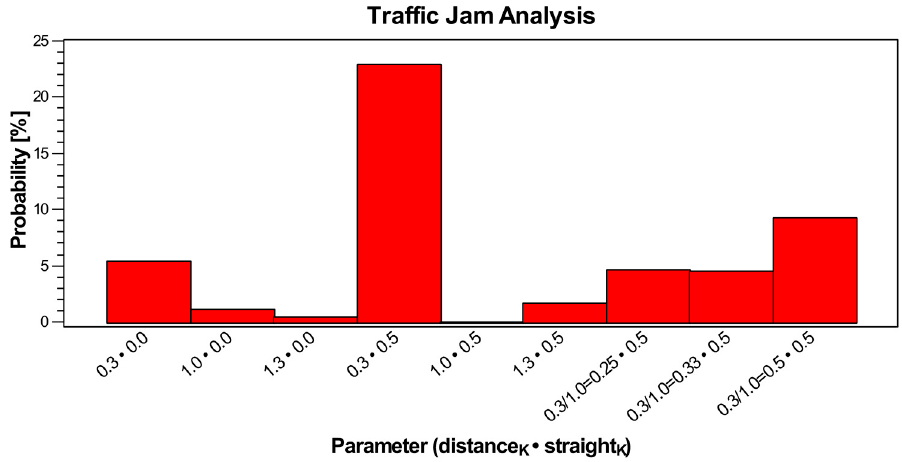
Figure 15. Simulation with 200 vehicles and different mobility parameters showing the probability of a jam.